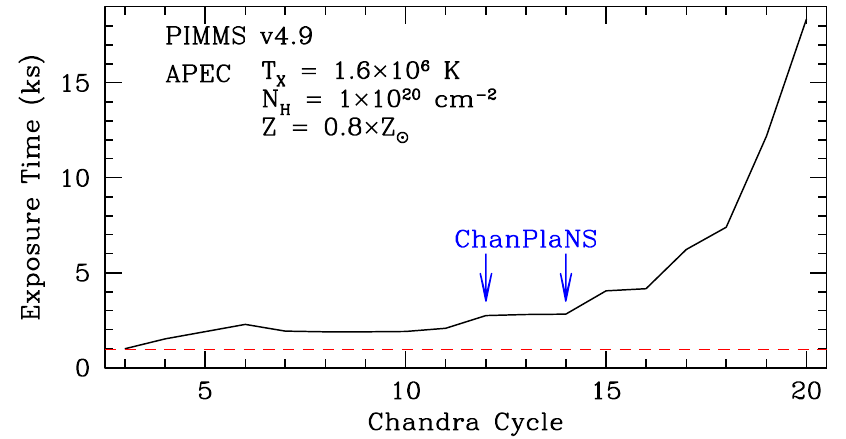
Figure 2. Time evolution of the exposure time required for a Chandra ACIS-S observation to obtain a given number of counts for a plasma model typical of the diffuse X-ray emission in PNe. Simulations were obtained using the Chandra PIMMS v4.9 simulator, which includes the most up-to-date calibrations. A plasma with a typical 1.6 × 10 6 K temperature, low hydrogen column density, and slightly subsolar chemical composition has been